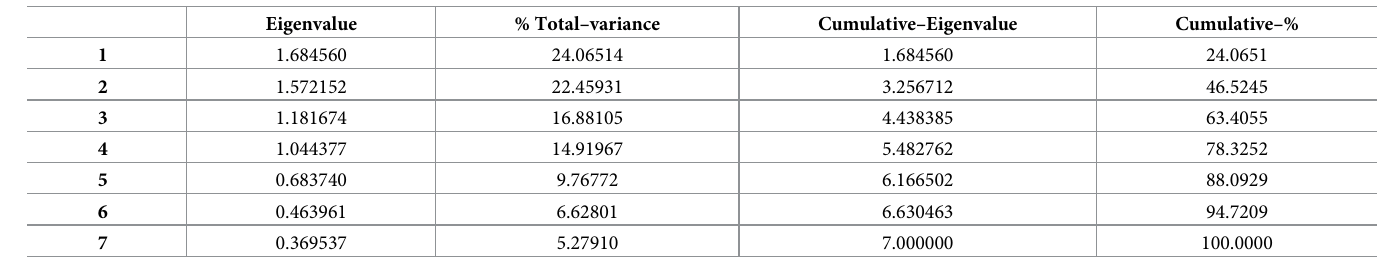
Table 1. Eigenvalues of indicators of financial and budgetary